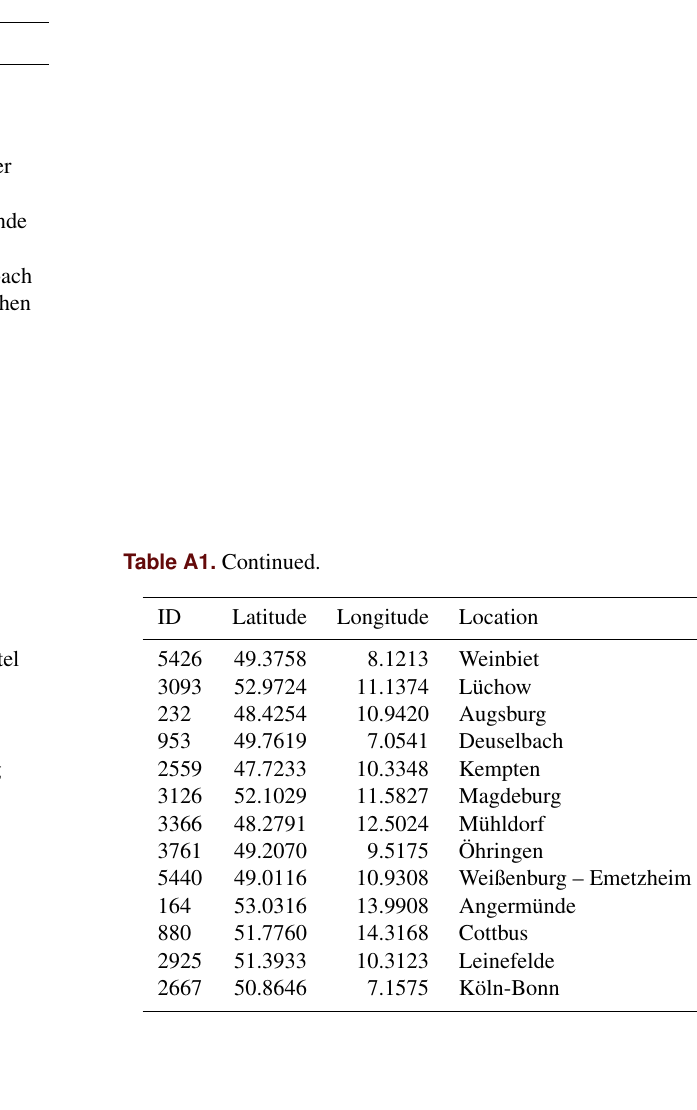
Table A1. DWD station IDs and